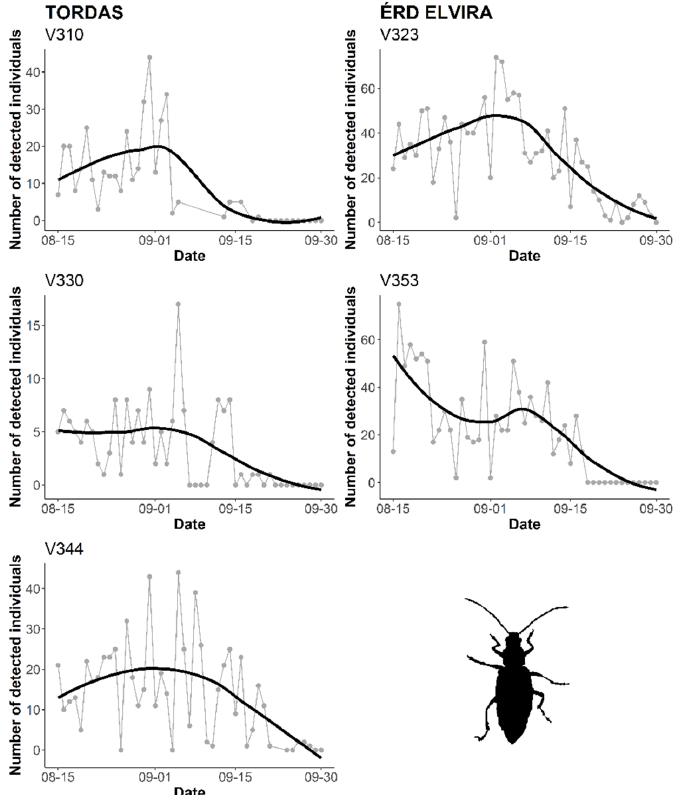
Figure 5. Continuous, automatic monitoring of D. v. virgifera by ZooLog KLP probes at Érd Elvira and Tordas research sites. For smooth curves, local polynomial regression fitting (locally estimated scatterplot smoothing, LOESS) was applied.